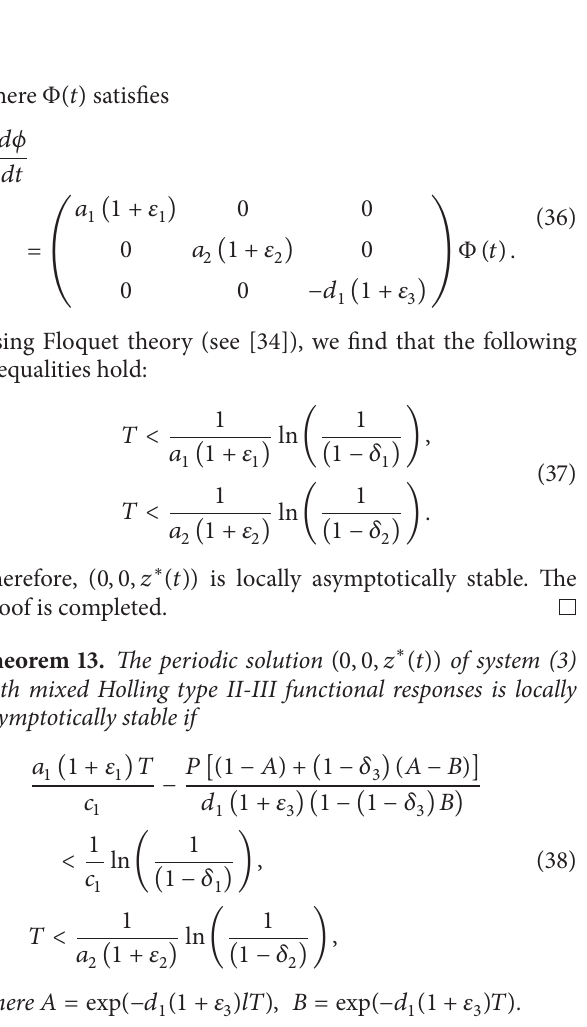
Figure 5: Bifurcation diagram of system (1) (a) with mixed Holling type II–IV responses and (b) with Holling type IV responses with respect to seasonal parameter 𝜓 with data set